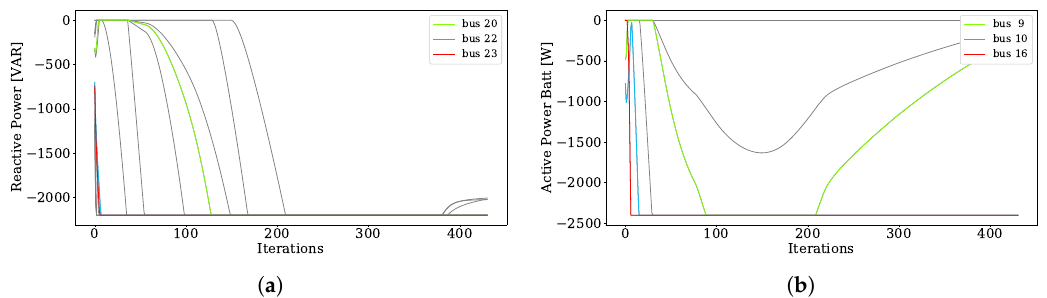
Figure 15. DG and ESS power injection in scenario with virtual nodes. ( a ) DG reactive power ( b ) ESS active